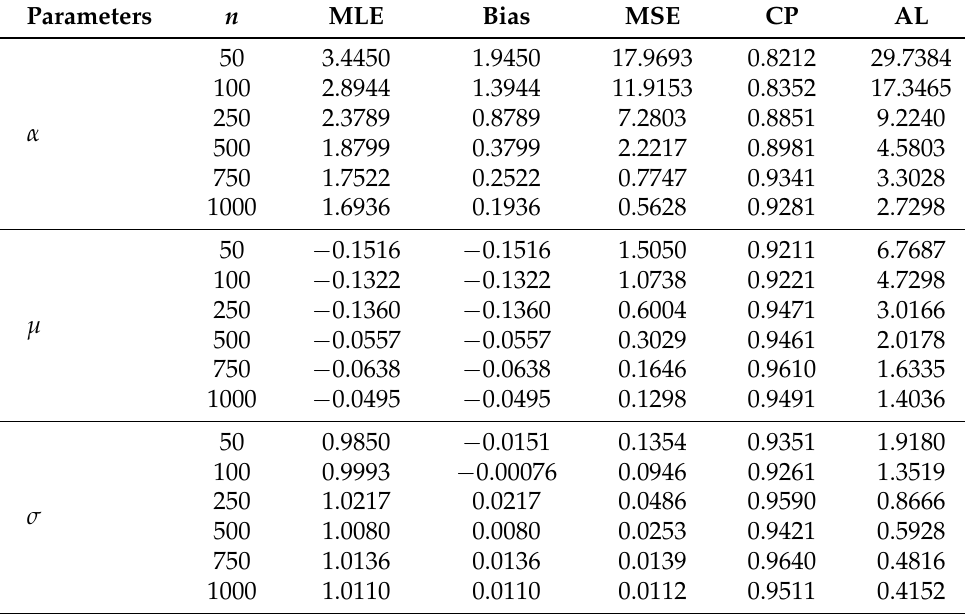
Table 2. The MLE simulation results for ( α = 1.5, µ = 0, σ = 1).